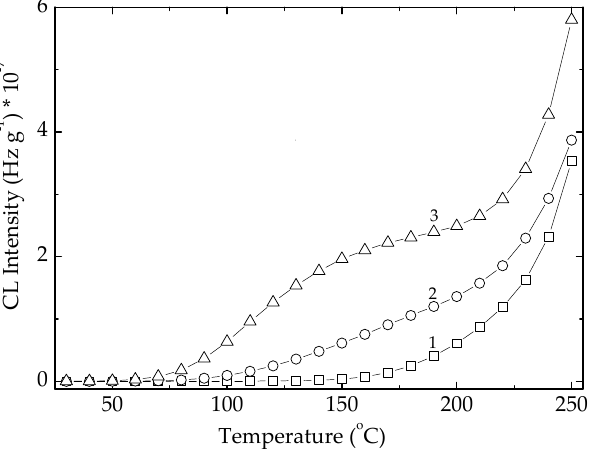
Figure 4. Non-isothermal CL spectra recorded on Ov-POSS powder at three irradiated doses. Heating rate: 10 °C min − 1 . (1) 0 kGy; (2) 25 kGy; (3) 100 kGy.